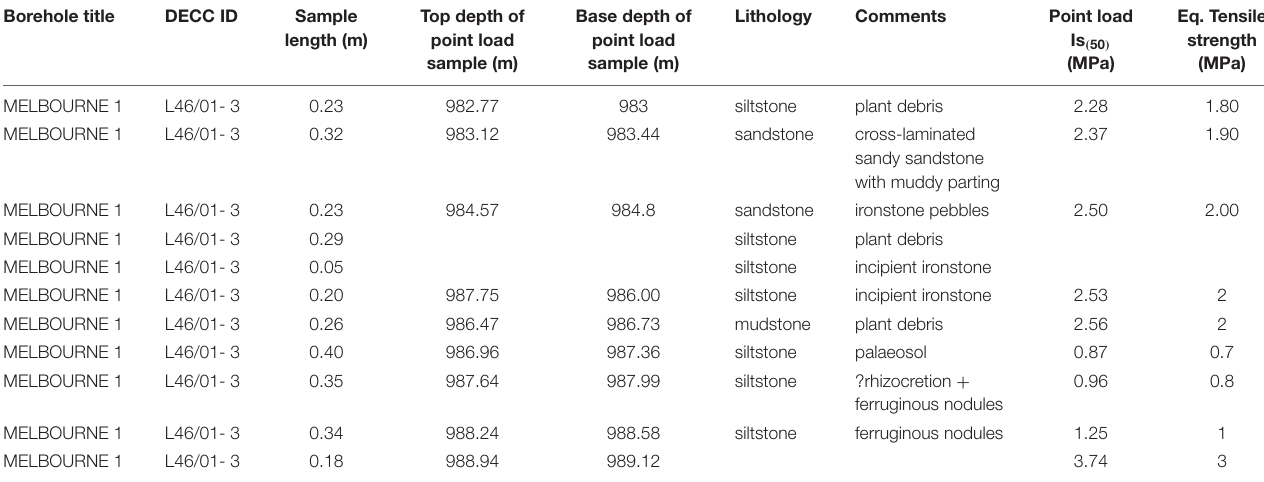
TABLE 3 | Point Load